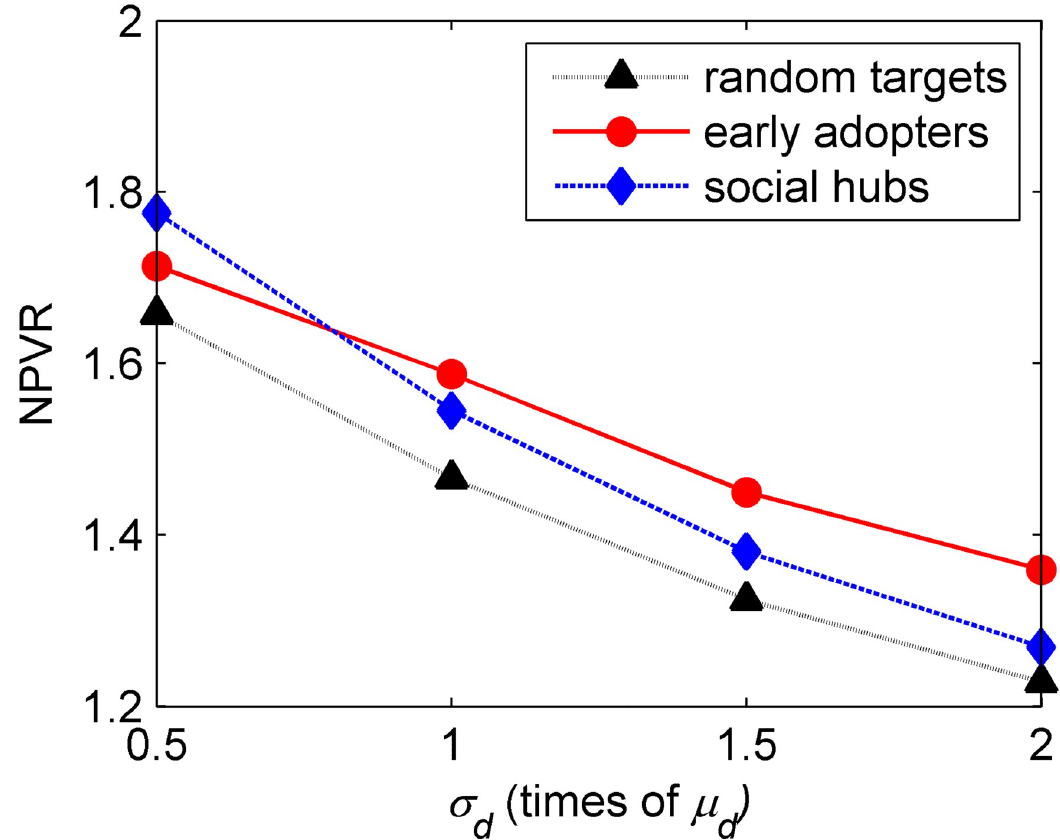
Fig 6. Impact of standard deviation of probability of consumers spreading negative WOM on the three seeding targets. In Fig.6, the abscissa represents the standard deviation of the probability of dissatisfaction, while the ordinate represents the change in the ratio of net present